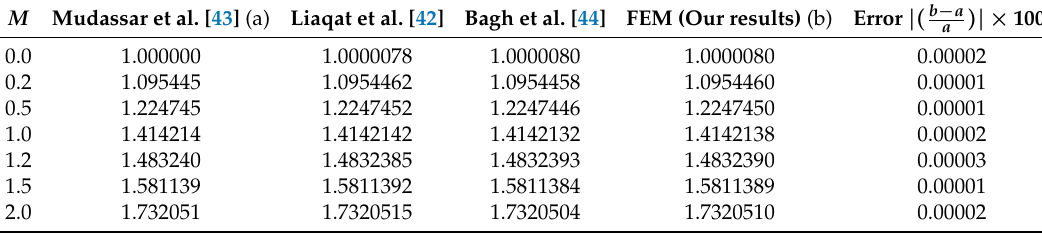
Table 2. Assessment of skin friction coefficient for different values of M , when Pr = λ 1 = 1, S 1 = 0.2, Le = 1, Nb = Nt = 0.1, S 2 = 0.2, α T = 0.05, λ = 0.5, λ 2 =